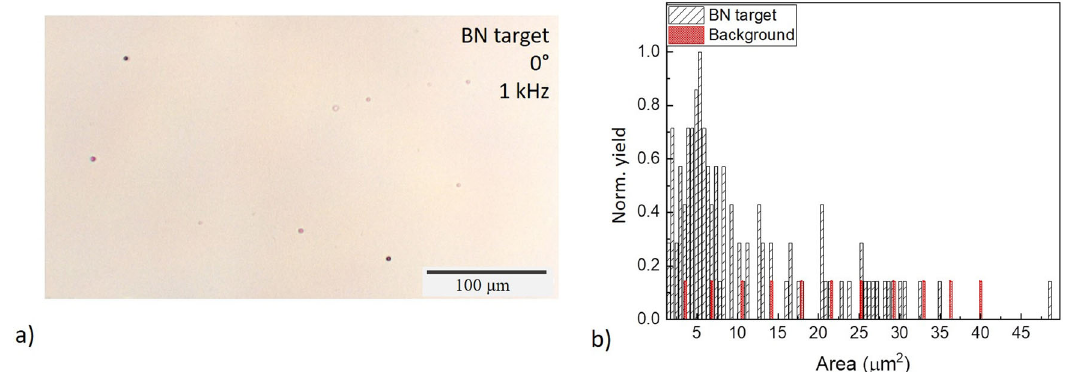
Fig. 5 Test at the kHz operation regime. a Example of the irradiated CR39 located at 0° of the fi ltered region (2.4 Al μ m) after 3 h of etching and recorded at 1-kHz repetition rate using a BN target. b The area distribution of the recorded particle tracks for all the CR39 samples under conditions described in